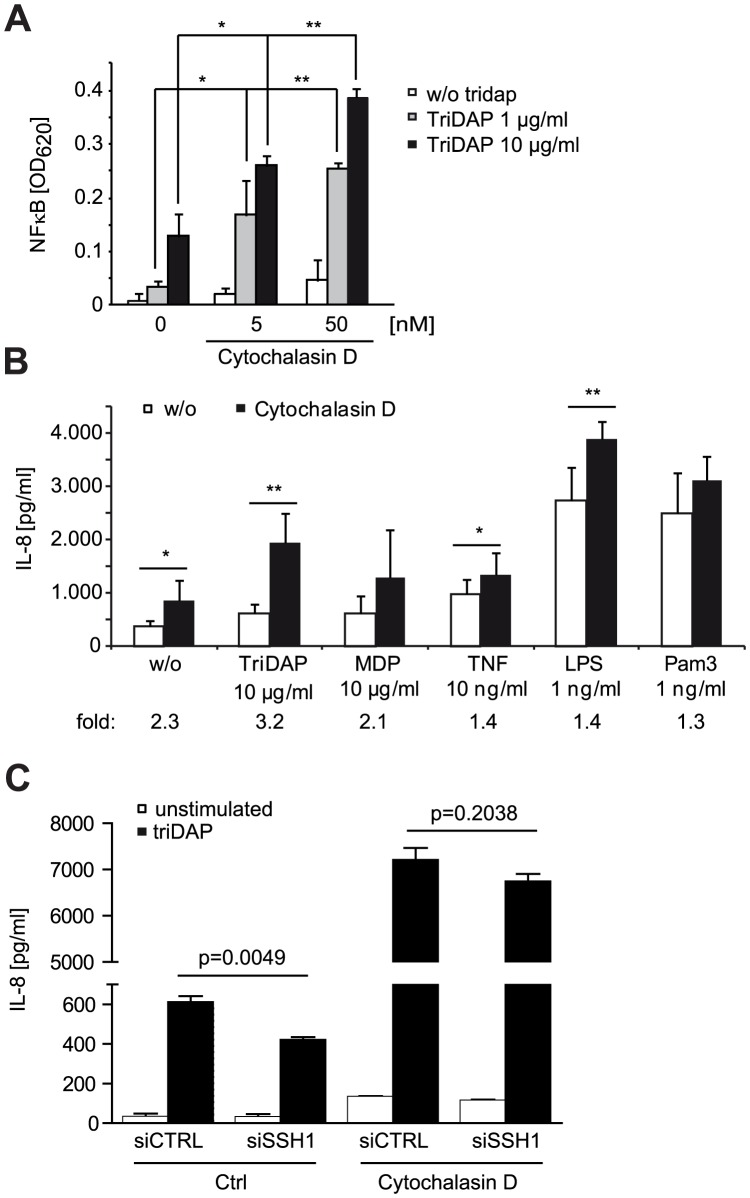
NOD1 signaling is dependent on F-actin.(A) Effect of 6 h cytochalasin D (cytoD) treatment on TriDAP/NOD1 induced NF-κB activation in PMA differentiated THP1-blue reporter cells. Mean + S.D. (n = 3). Significance was calculated by student's t-test (unpaired, two-tailed) *p<0.05, **p<0.005 (compared to 0 nM cytoD). (B) IL-8 secretion of THP1 cells treated for 6 h with the indicated PAMP in the presence or absence of cytochalasin D. Shown is the mean of triplicates from two independent experiments + S.D. (n = 6). The fold induction of IL-8 by cytoD is depicted below. (C) SSH1 knock-down effect on cytoD enhanced NOD1 signaling. Differentiated THP1 cells were treated with cytoD for 6 h and stimulated with 10 µg/ml TriDAP (black bars) or mock treated (open bars). IL-8 secretion measured in the supernatant after 6 h of incubation is shown, mean + S.D. (n = 3), * p<0.05, ** p<0.005.